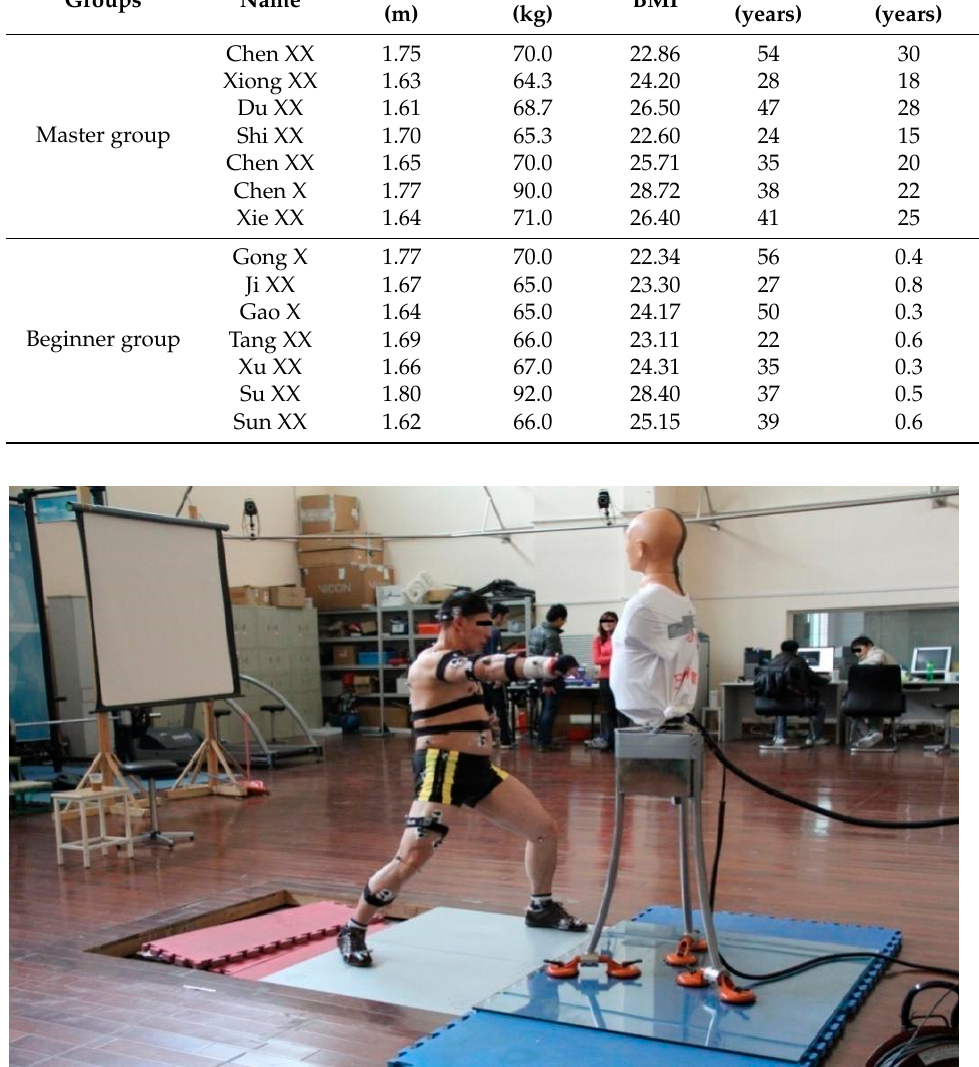
Figure 1. Cover hands and punch with arm action schematic diagram.